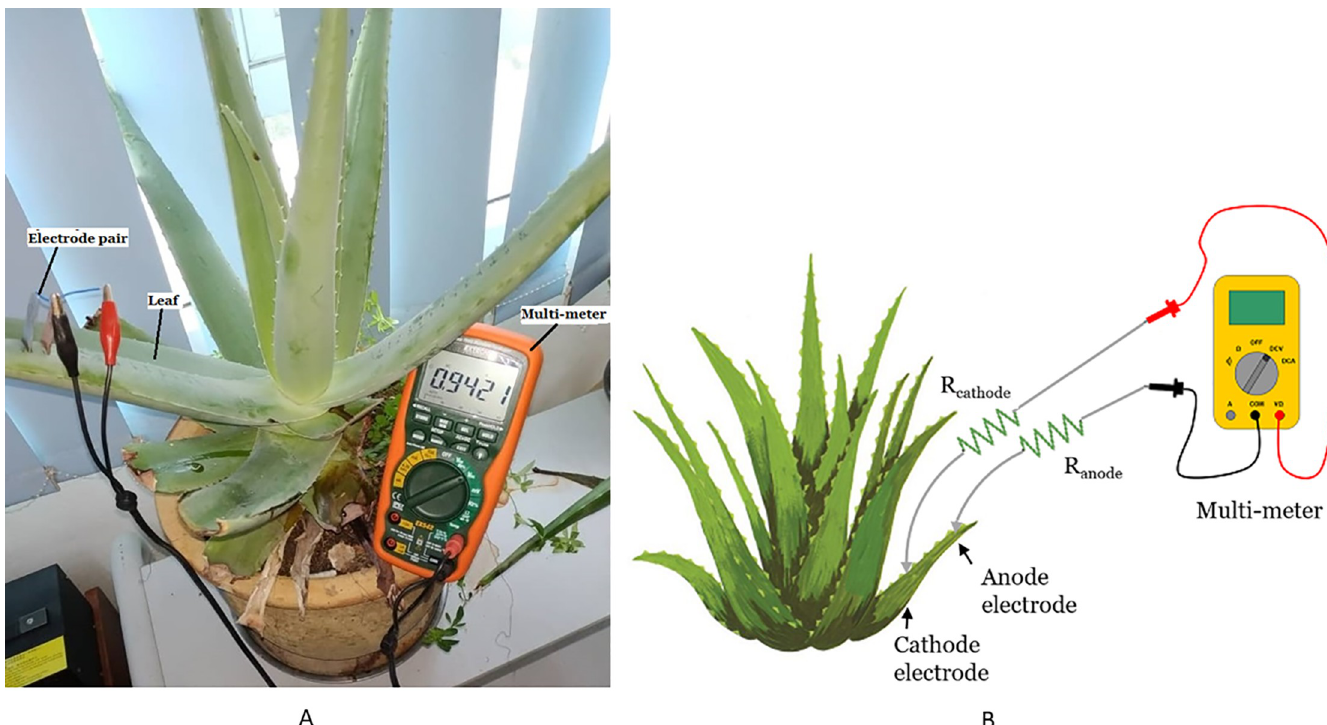
Fig 1. Experiment setup for harvesting energy from Aloe Vera with different electrode combinations. Example of setup arrangement (A) and simple schematic of the setup (B).